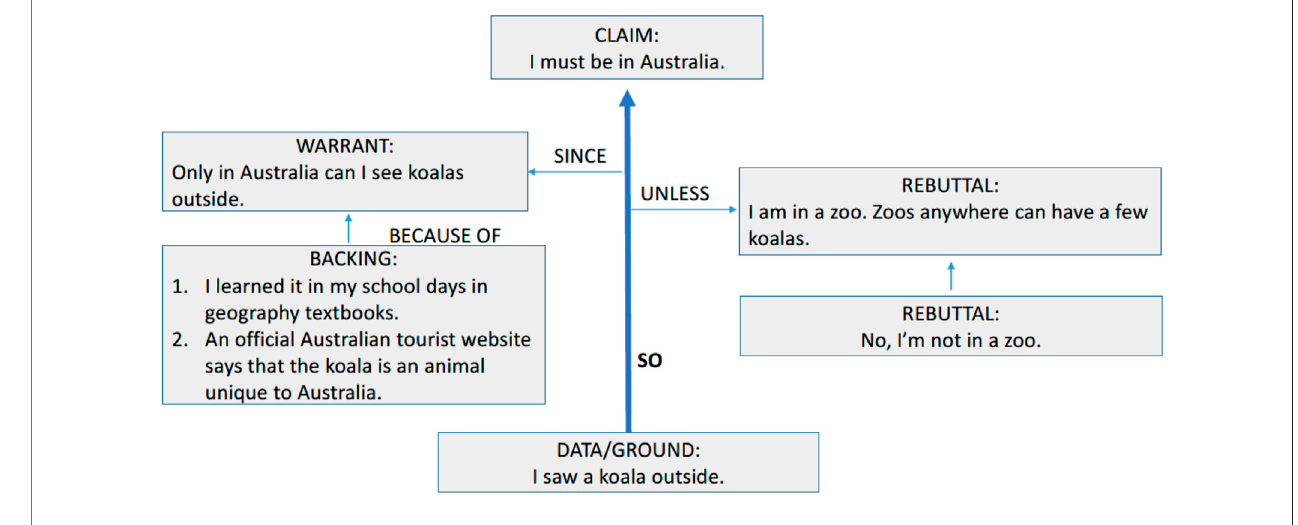
FIGURE 2 | Argument structure for a simple claim/conclusion.